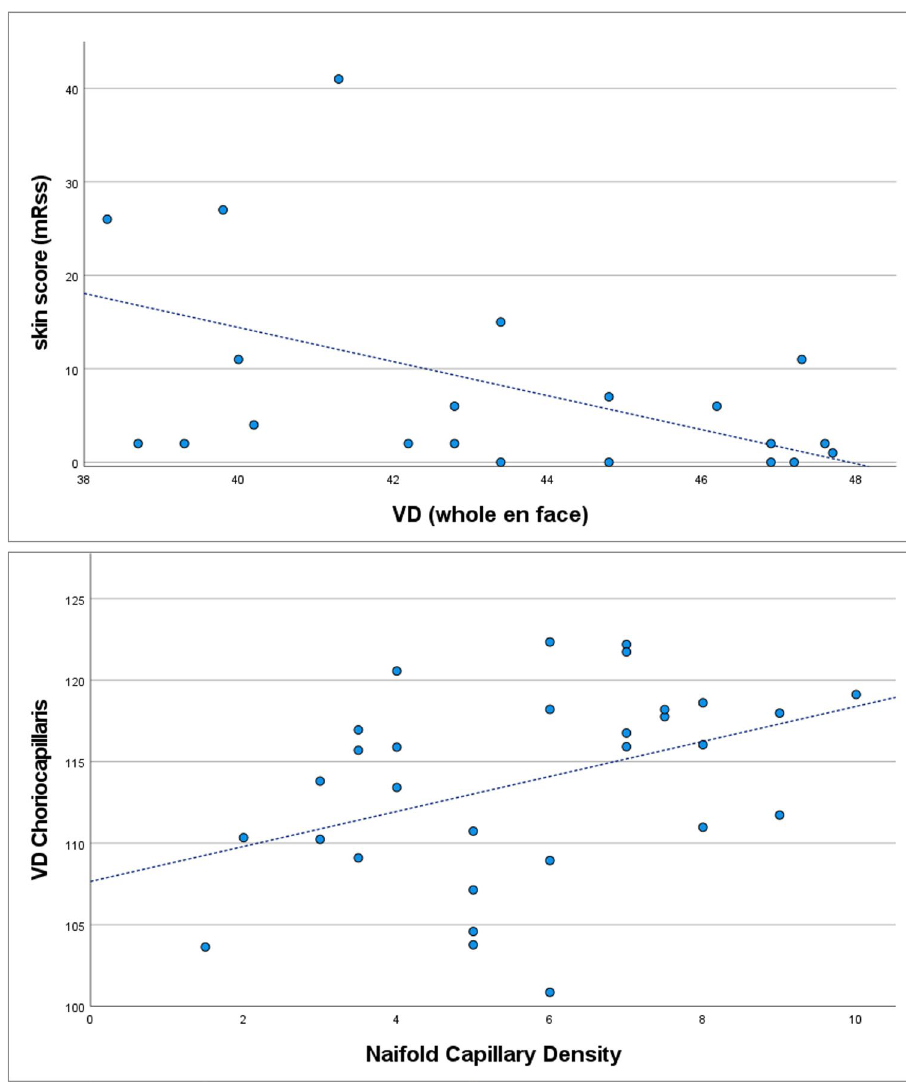
Figure 2. Correlation analysis. Correlation analysis between ( A ) the vessel density (VD) obtained in the superficial OCT angiogram of the macula (whole en face) and the modified Rodnan skin score (mRSS) (Spearman coefficient (rSp) = − 0.504; p = 0.017), and ( B ) the VD of the choriocapillaris and the nailfold capillary density (rSp = 0.456, p =